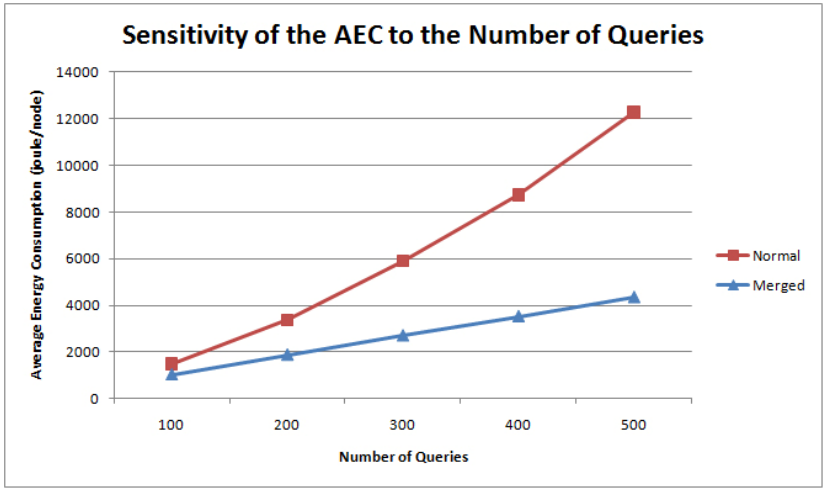
Figure 12. Sensitivity of the AEC to the number of